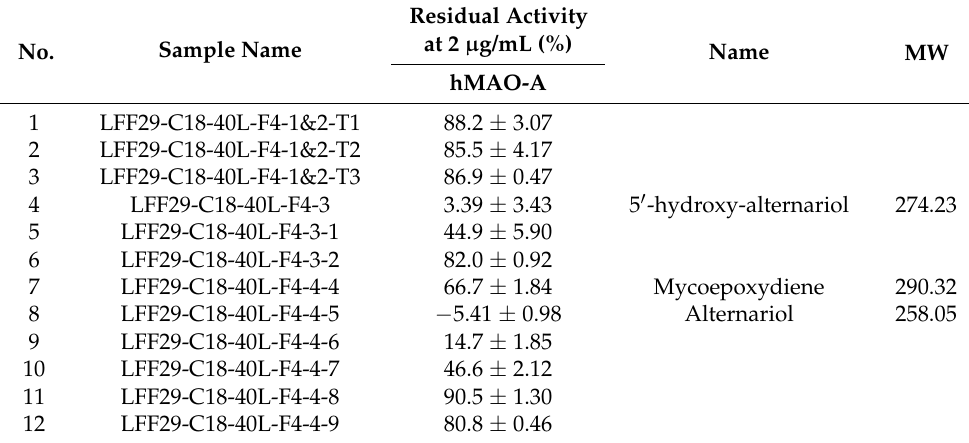
J. Fungi 2021 , 7 , x FOR PEER REVIEW Results are expressed as mean and standard deviation from duplicate experiments.